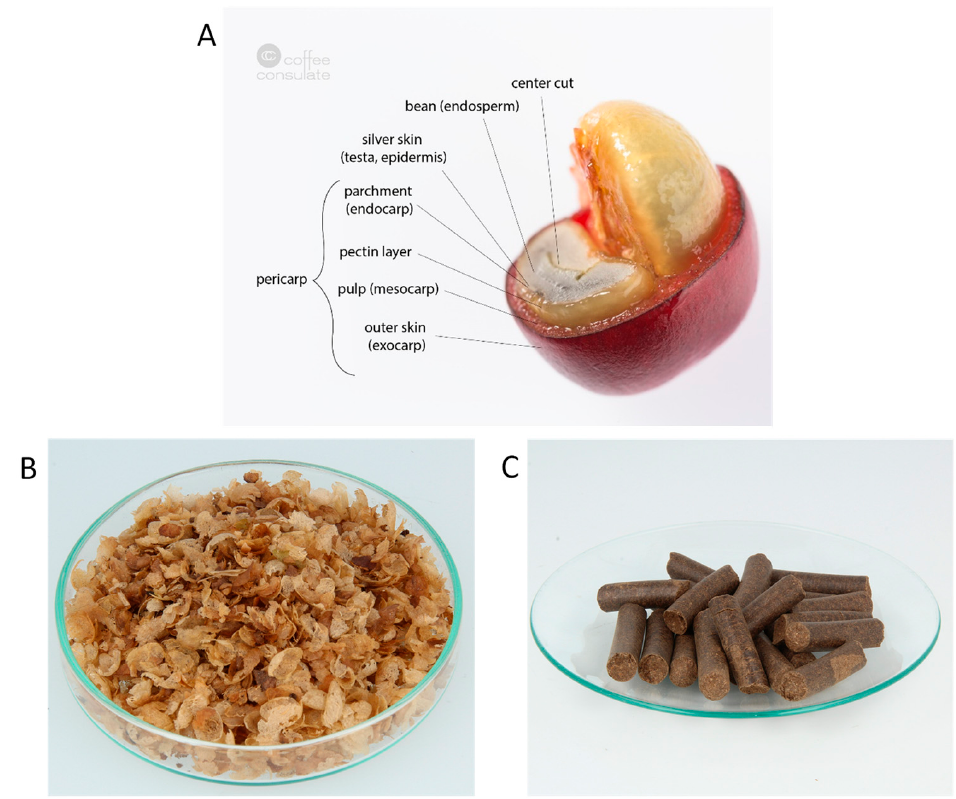
Figure 1. Profile of a coffee cherry with its various layers ( A ) [5], photo of coffee silver skin ( B ) [5], and photo of coffee silver skin pellets ( C ).